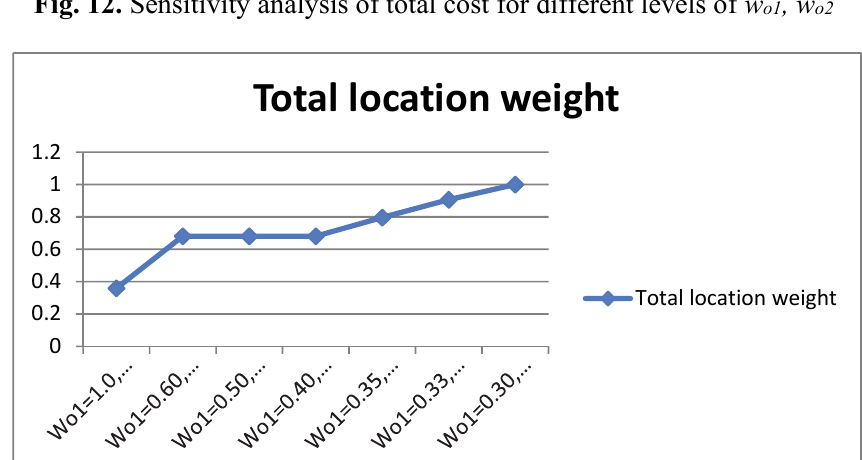
Fig. 13. Sensitivity analysis of total location weight for different levels of w o1 , w